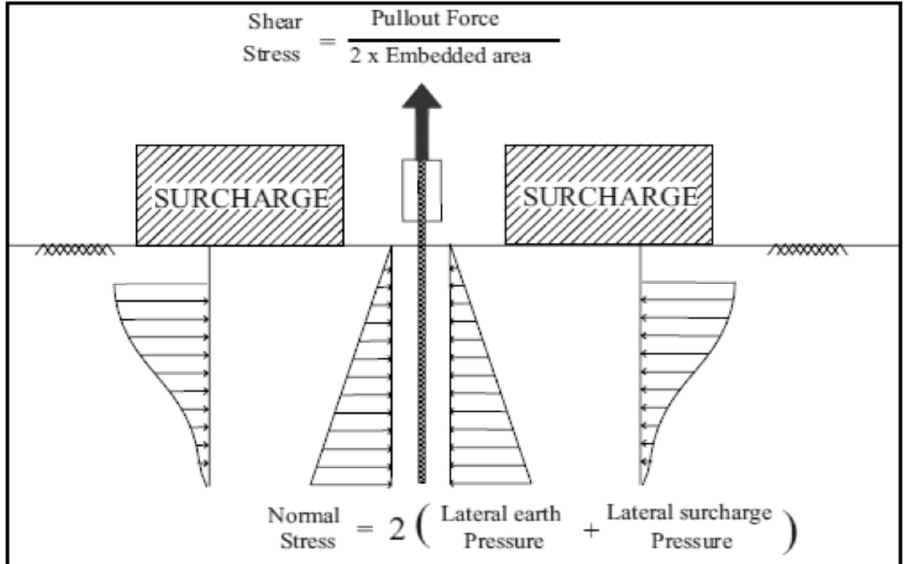
Figure 5. Surcharge load application philosophy .